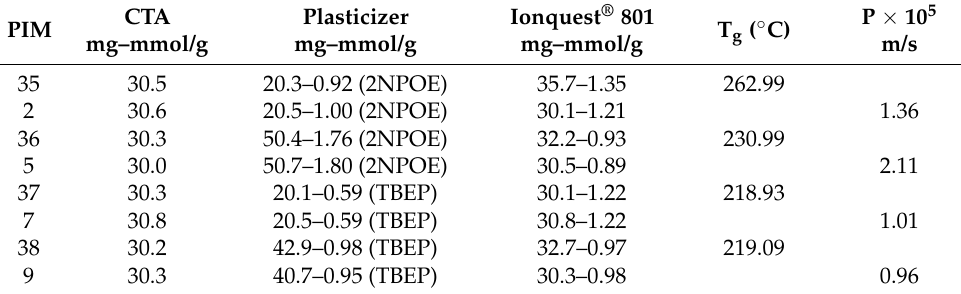
Table 9. T g values and permeabilities for PIMs with 2NPOE and TBEP. PIM